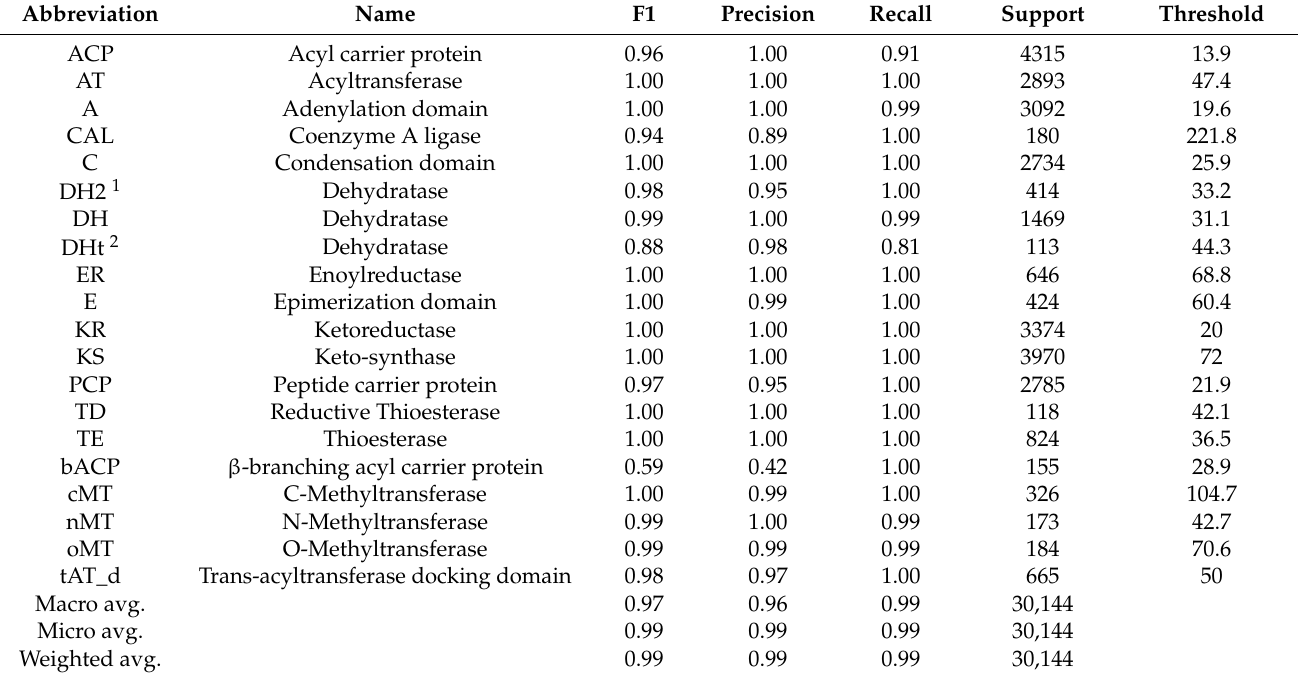
Table 1. Cross-validation results and detection thresholds for biosynthetic domains used in the pipeline. The detection thresholds are referred to as domT by the HMMER manual [15].